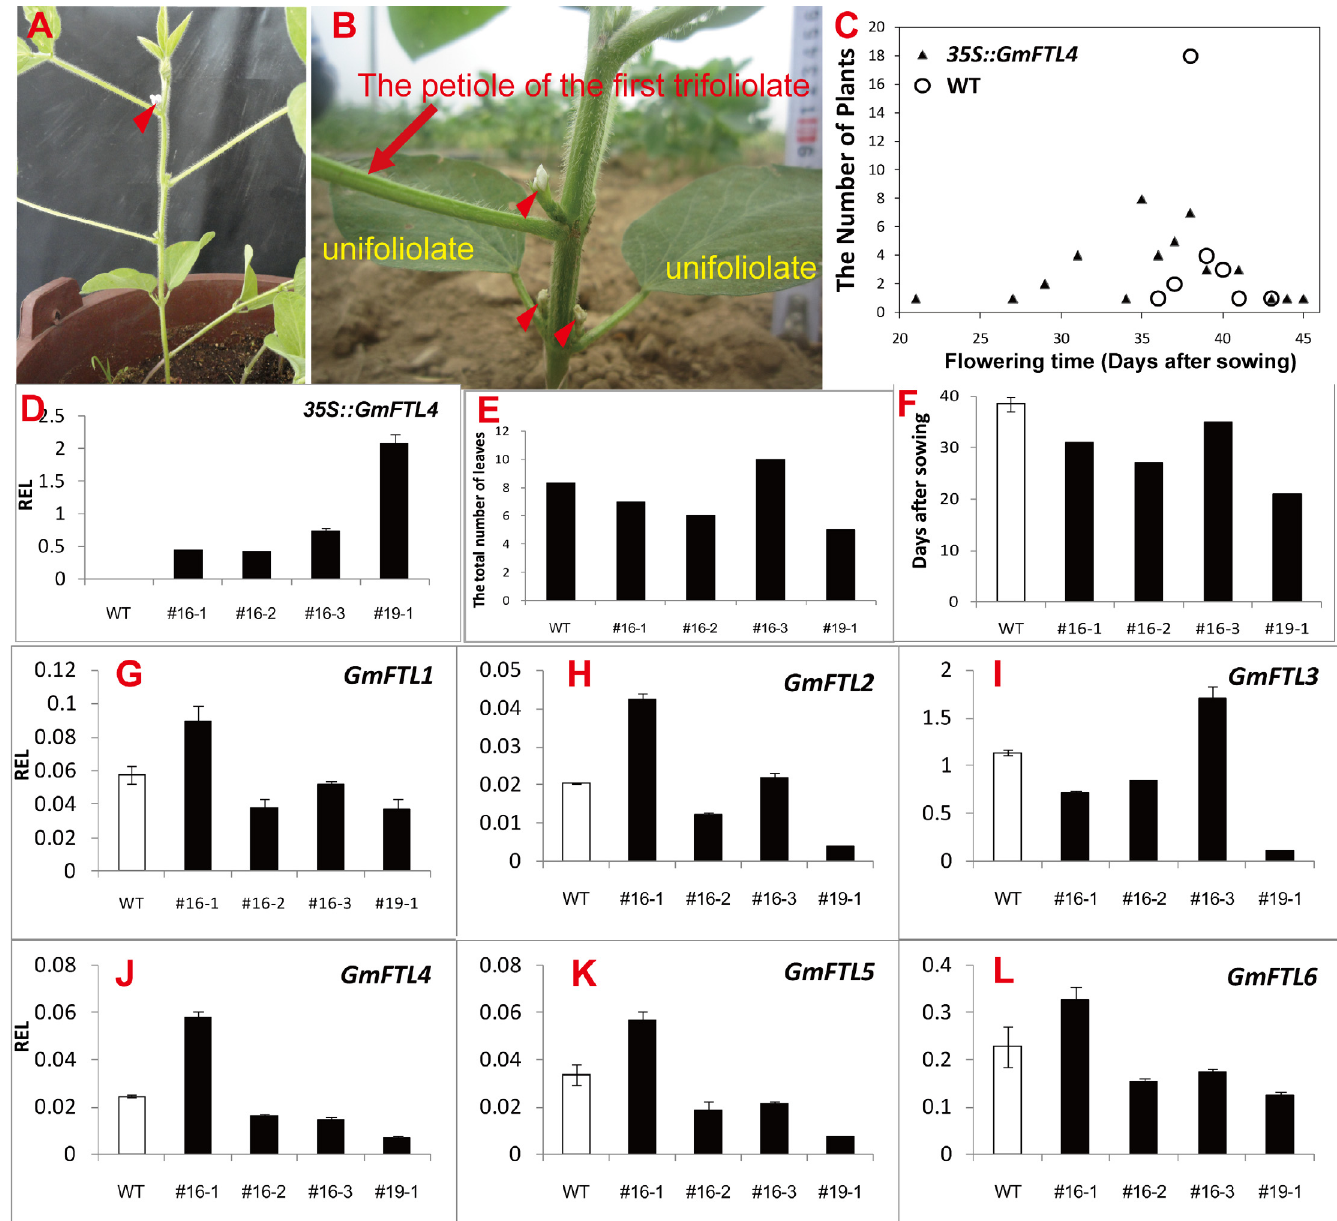
Fig 9. Overexpression of GmFTL4 causes precocious flowering in the soybean cultivar Tianlong 1. (A) A wild-type Tianlong 1 plant showing the first flower appearing at the 3 rd trifoliolate axil (red arrow-heads). (B) A transgenic line indicating flowers (red arrow-heads) appearing at the unifoliate (yellow words) and the first trifoliolate axil (red arrow and words indicating the petiole of the first trifoliolate). (C) The flowering times of different transgenic lines compared with wild-type plants (WT). (D) Relative expression level (REL) analyses of transgene-derived GmFTL4 in transgenic lines and wild-type plants (WT). The total number of leaves at flowering and flowering times of the transgenic plants were shown in (E) and (F), respectively. (G) to (L) Relative expression level analyses of endogenous GmFTLs in transgenic lines in field conditions. Trifoliolates were sampled at 40 days after